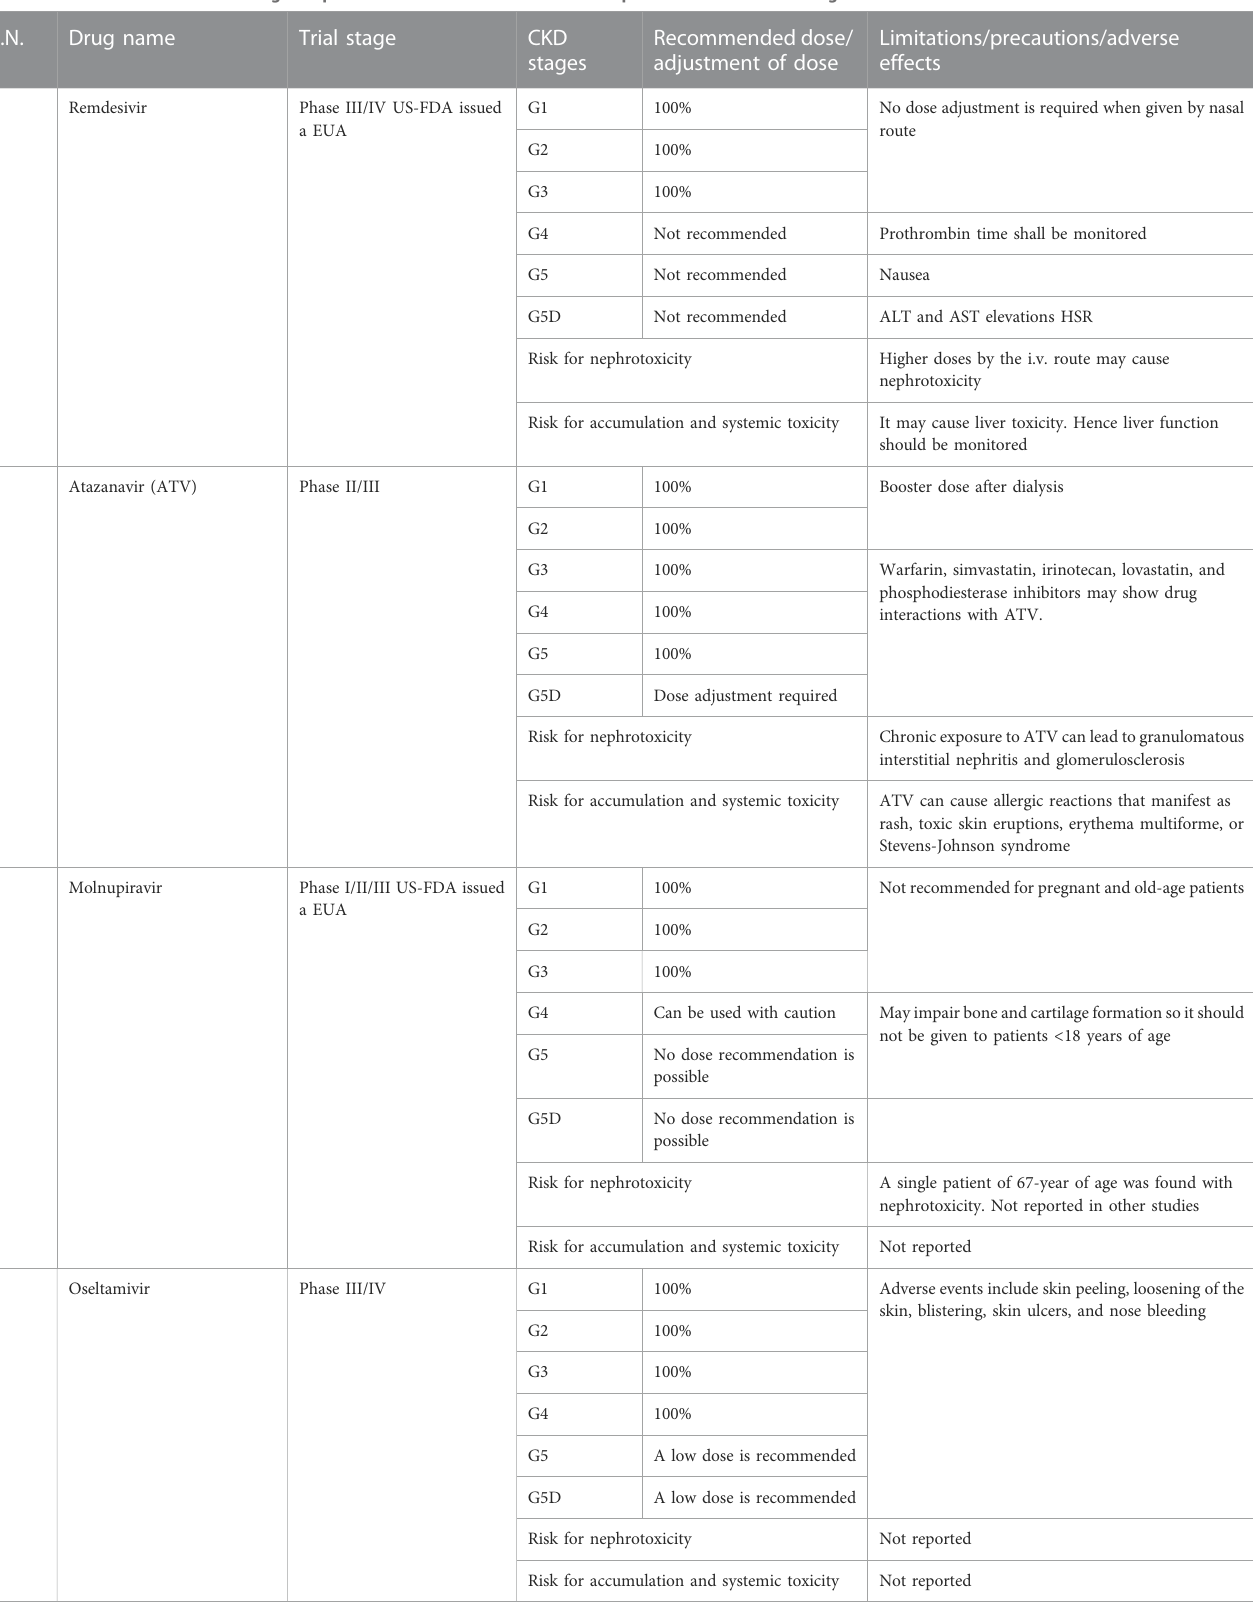
TABLE 1 Recommendations for dosing and precautions of antivirals in COVID-19 patients with different stages of CKD.